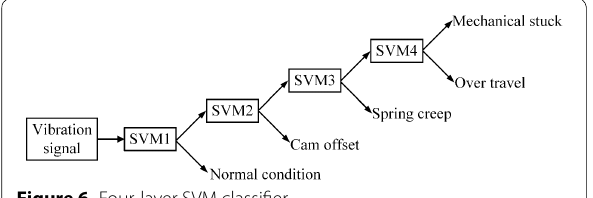
Figure 6 Four-layer SVM